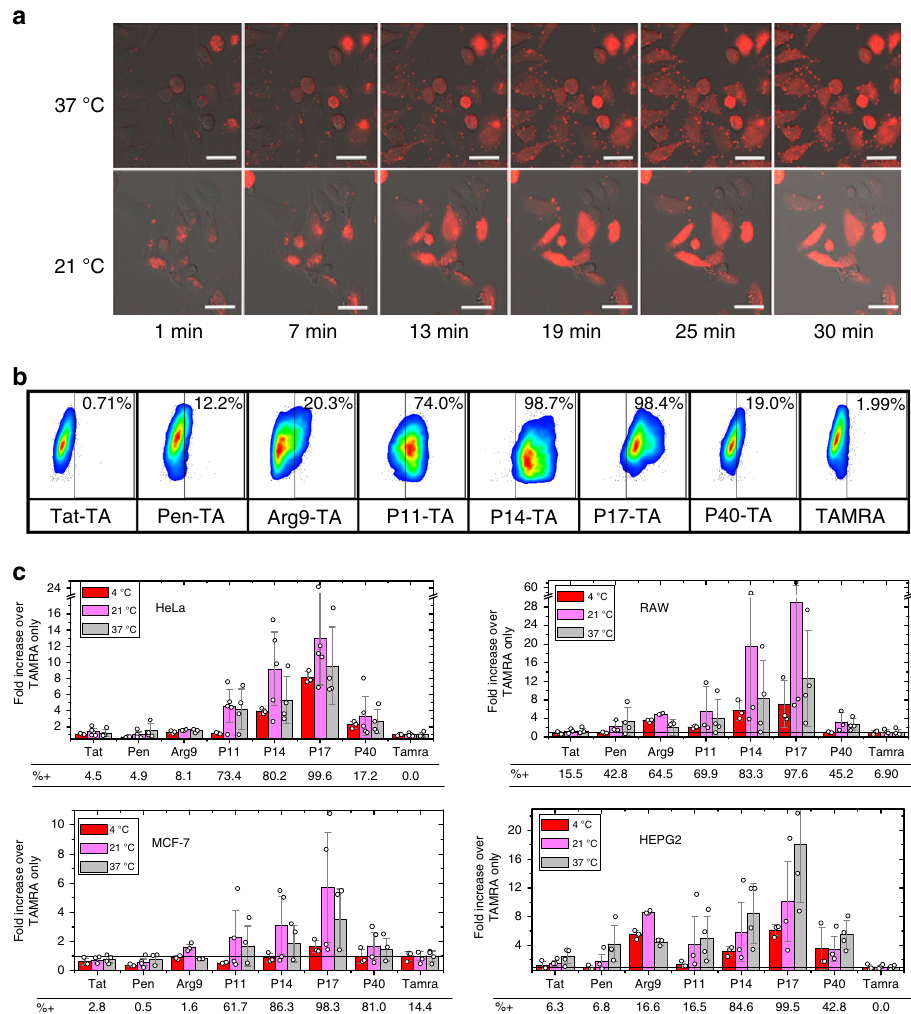
Fig. 3 PDEP-mediated delivery of the fl uorescent dye TAMRA. a Confocal microscopy images of HeLa cells incubated for 30-min with 4.5 µ M P17-C + 0.5 μ M P17-C-TA at either 37 °C or at room temperature (21 °C). The cytolysis-sensitive dye SYTOX Green was also added. Scale bar = 10 μ M. b Example fl ow cytometry results for peptide-TA conjugates. Cells were trypsinized to remove externally bound peptides and subjected to fl ow cytometry. Cells were gated by scatter to select single viable cells. The very small fraction of SYTOX Green positive cells were excluded. The threshold for TAMRA positive intensity was set to be just above that of cells treated with free TAMRA dye, which does not enter cells. c For the four cell types shown, the averages of TAMRA fl uorescence of live, SYTOX Green-negative cells were measured after treatment as above at 4 °C, 21 °C, and 37 °C. Averages are plotted as a ratio of the intensity of peptide-TA-treated cells to the intensity of cells treated with free TAMRA. Error bars are standard deviations of the data, which are shown as open circles, with 3 – 4 data points, from independent experiments, per